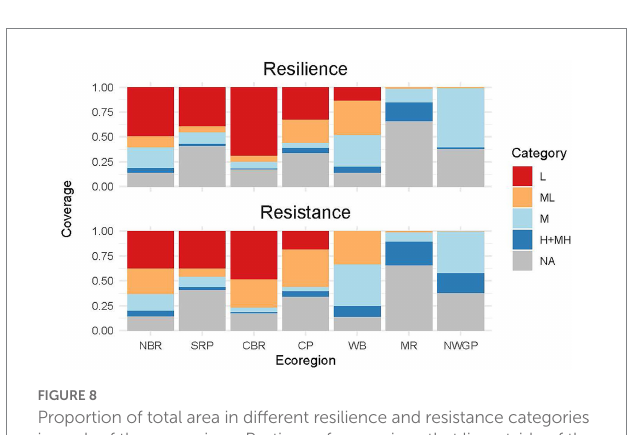
FIGURE 8 Proportion of total area in different resilience and resistance categories in each of the ecoregions. Portions of ecoregions that lie outside of the sagebrush biome are unclassified (“NA”). NBR, Northern Basin and Range; SRP, Snake River Plain; CBR, Central Basin and Range; CP, Colorado Plateau; WB, Wyoming Basin; MR, Middle Rockies; NWGP, Northwestern Great Plains.